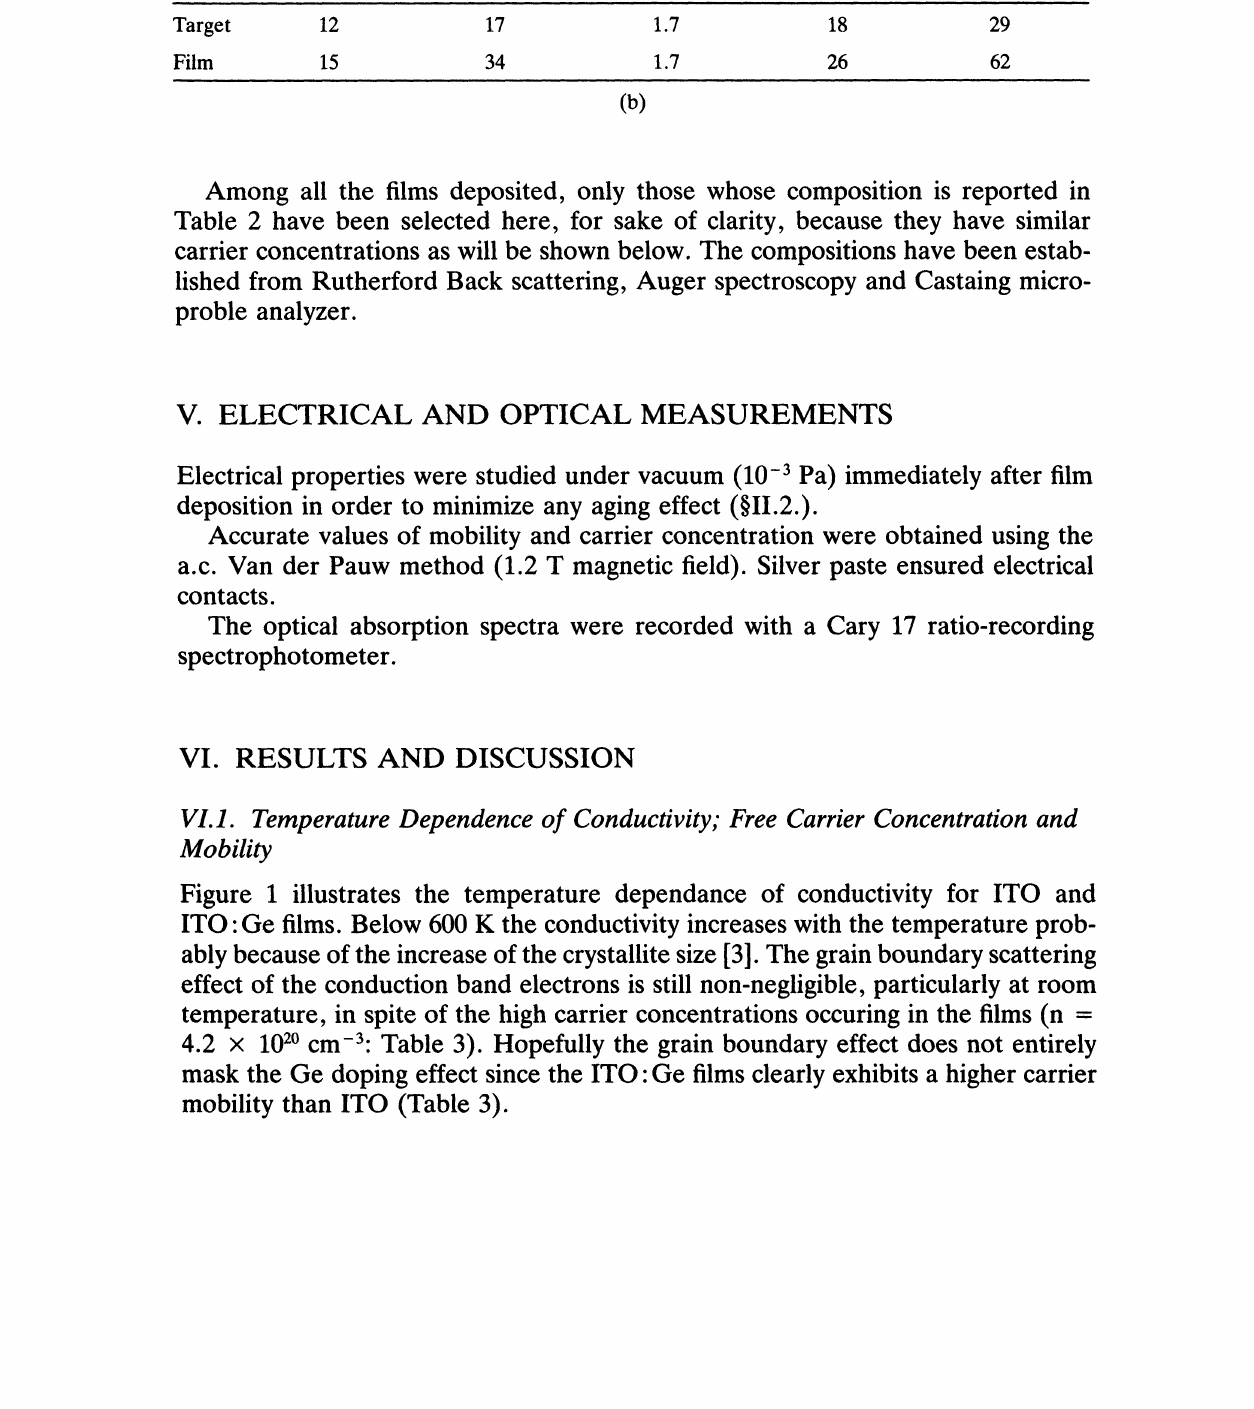
Target and film compositions for ITO (a) and ITO:Ge